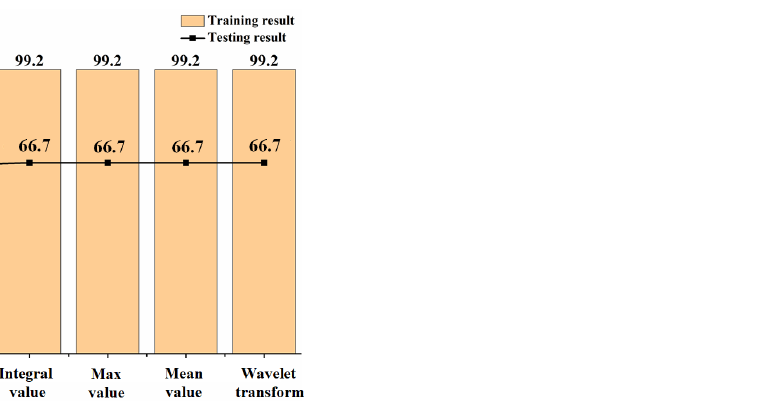
Figure 6. The recognition results of source domain sample models for target domain samples based on different feature extraction methods. ( a ) qualitative analysis, ( b ) chlorothalonil semi-quantitative analysis, ( c ) chlorpyrifos semi-quantitative analysis, ( d ) lindane semi-quantitative analysis, ( e ) malathion semi-quantitative